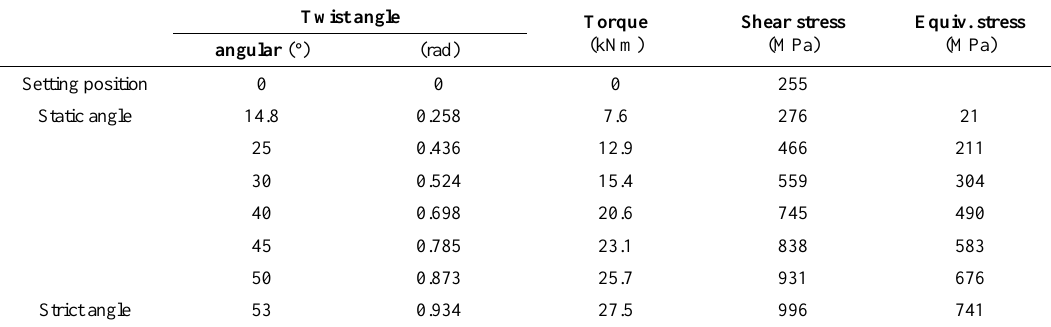
Table 5. Values of twisting moment and shear stress at twist angle.